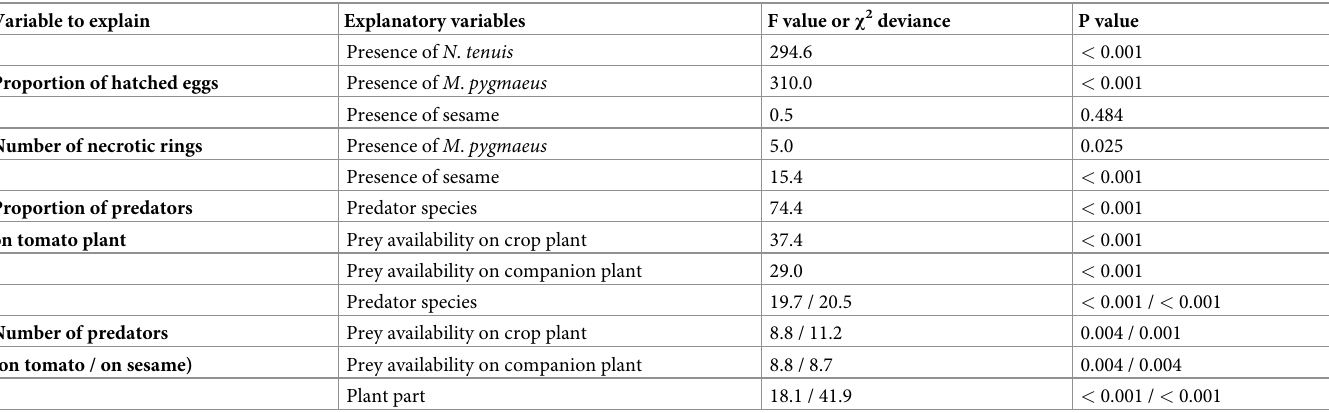
Table 1. Results of the linear (F value) and Generalized Linear Model ( χ 2 deviance).